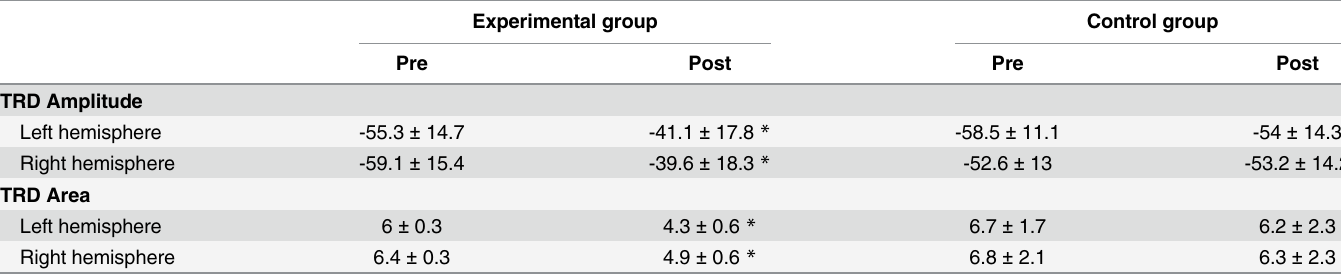
Table 2. Pre and post mu TRD values.